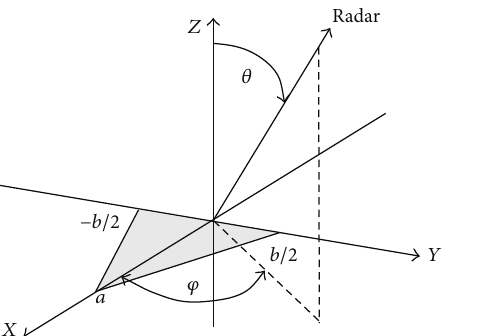
Figure 12: Coordinates for a perfectly conducting isosceles triangu- lar flat plate.